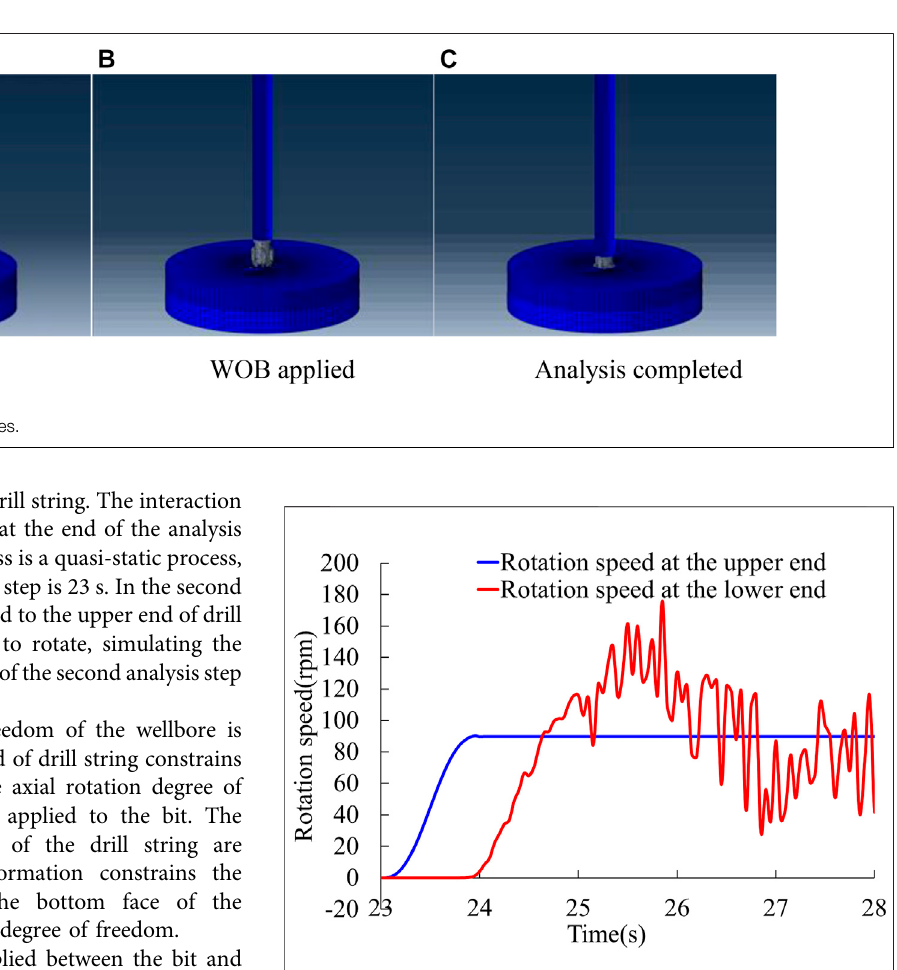
FIGURE 5 | Rotation speed at the upper end and the lower end of drill string when the initial WOB is 80 kN and the Rotation speed at upper end is 90